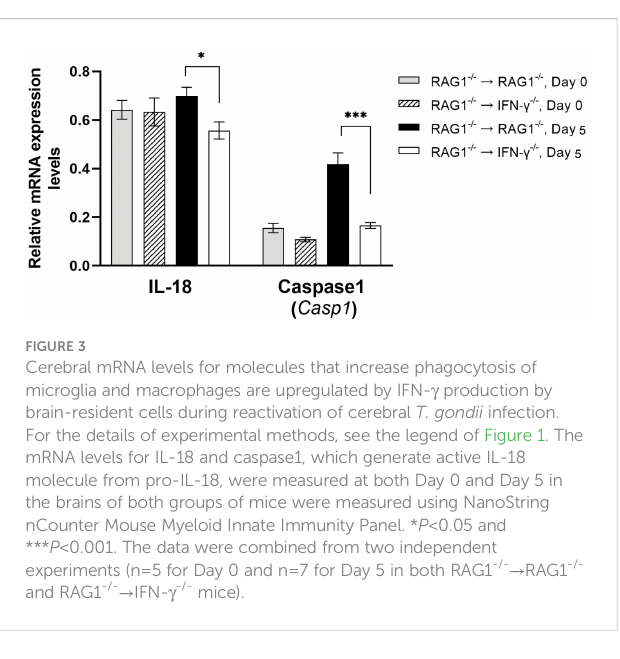
two independent experiments (n=5 for Day 0 and n=7 for Day 5 in both RAG1 -/- → RAG1 -/- and RAG1 -/- → IFN- g -/-